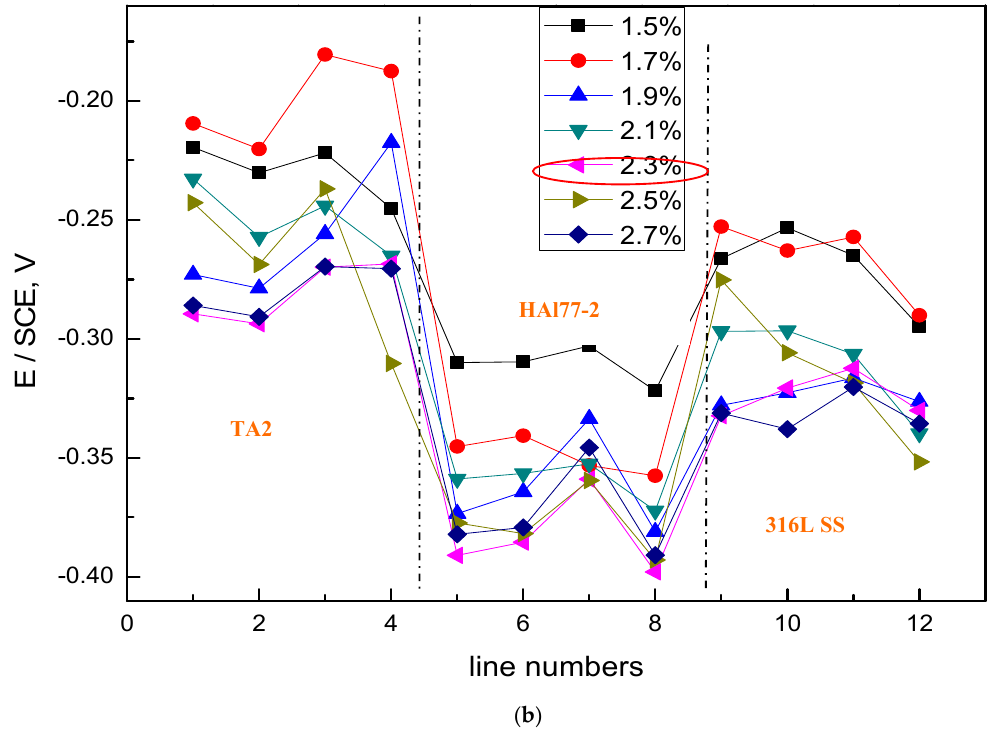
Figure 14. Average potential and corresponding current distributions of each CMEA3 microelectrode line after being short-circuited for 12 h in artificial seawater with different concentrations of chloride ions (wt %): ( a ) average potential; and ( b ) average current.